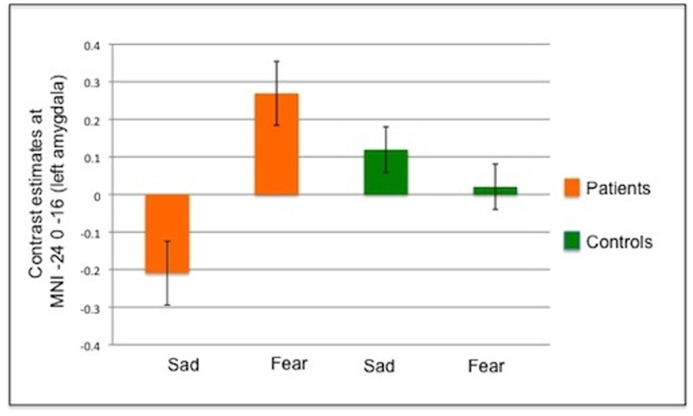
ROI analysis: Interaction effect in the Linear-change Model.Graph showing group-level beta estimates for the linear change in the responsiveness of the left amygdala to the presentation of emotional stimuli. Here a positive beta indicates a linear increase in the magnitude of the response elicited by stimuli following repeated exposure. Negative betas indicate the response amplitude reduced over time (see S1 Fig for a graphical representation of the predicted BOLD time series scaled by these group beta coefficients).